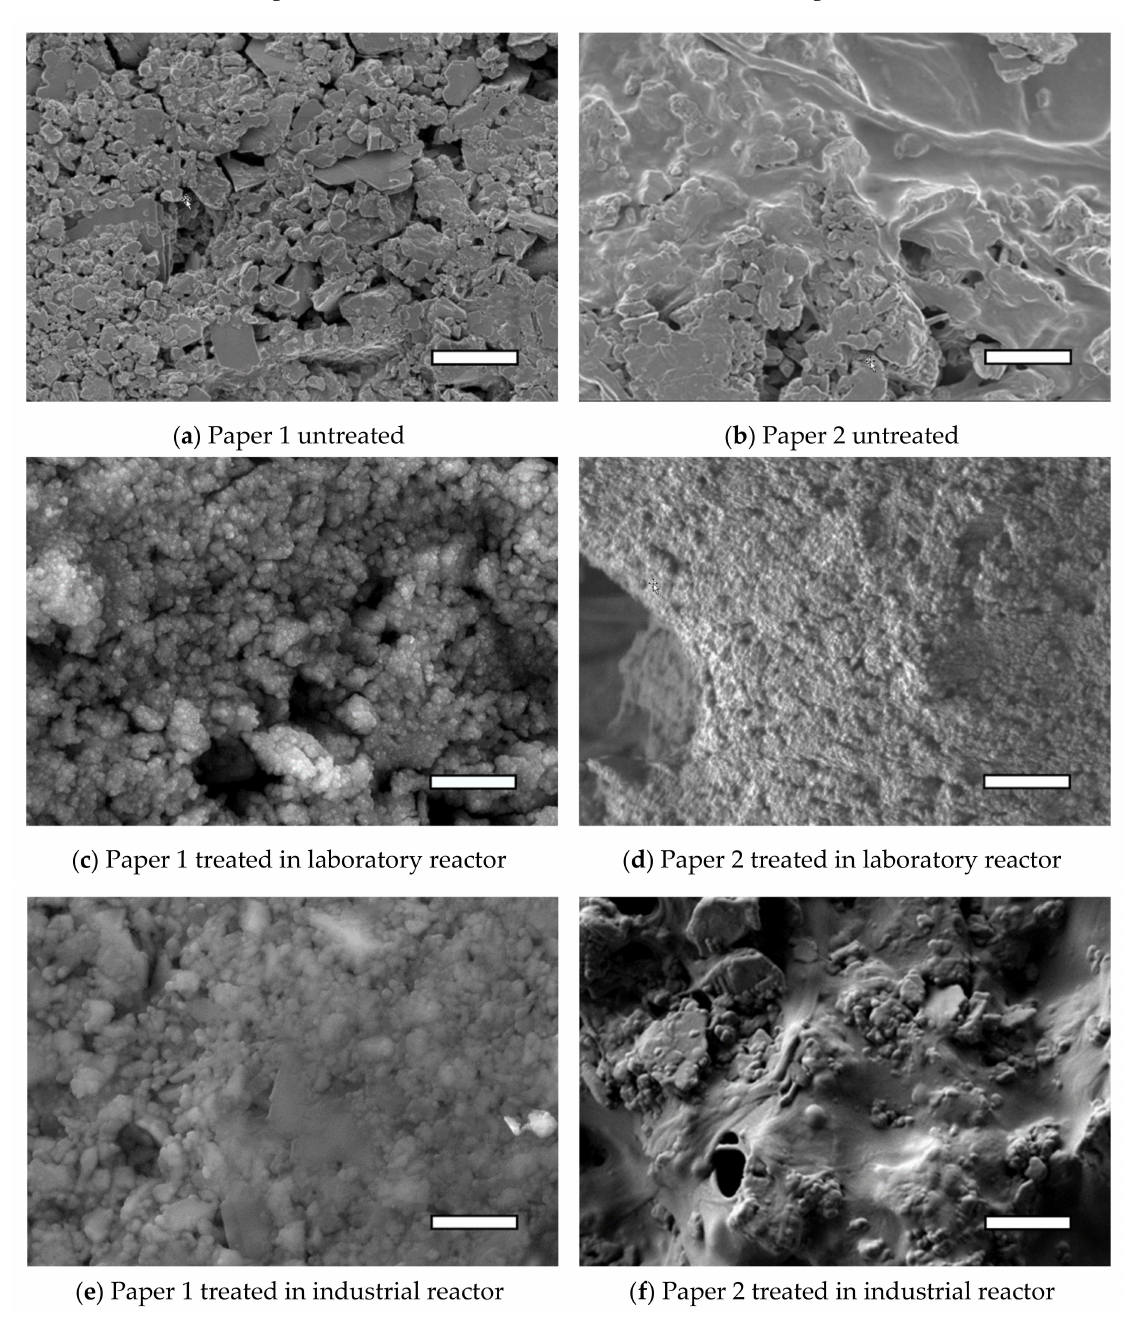
Figure 2. Comparison of SEM, higher magnification coatings on paper 1 and 2 with two different plasma systems. On the left there is paper 1, ( a ) untreated, ( c ) treated in laboratory reactor, ( e ) treated in industrial reactor. On the right there is paper 2, ( b ) untreated, ( d ) treated in laboratory reactor, ( f ) treated in industrial reactor. White bar represents 1 µ m